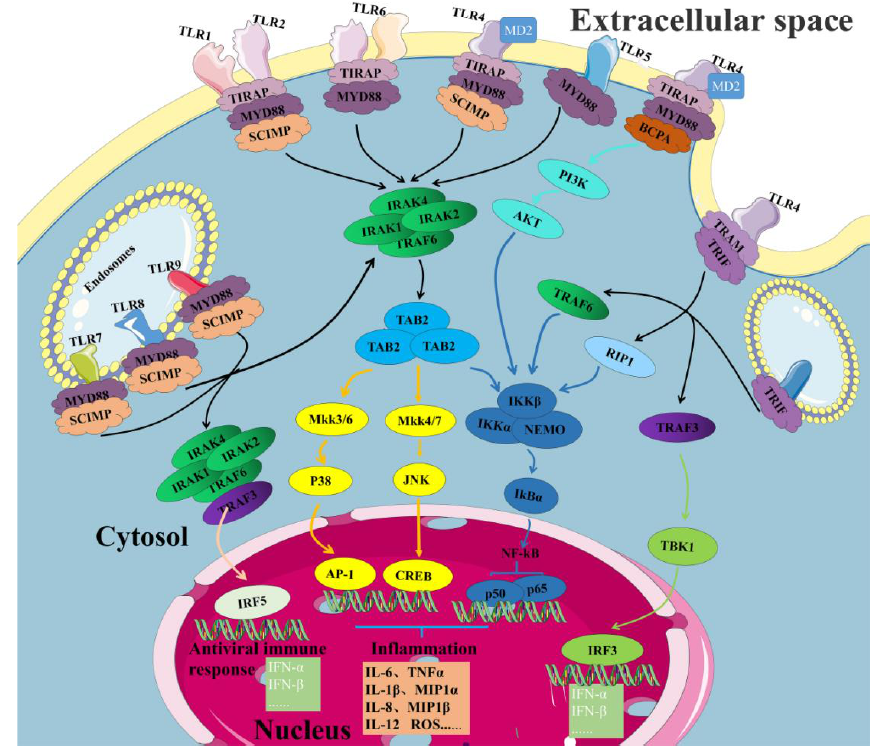
Figure 4. TLR signaling pathway. TLRs can be expressed on the surface of cells or inside cells.